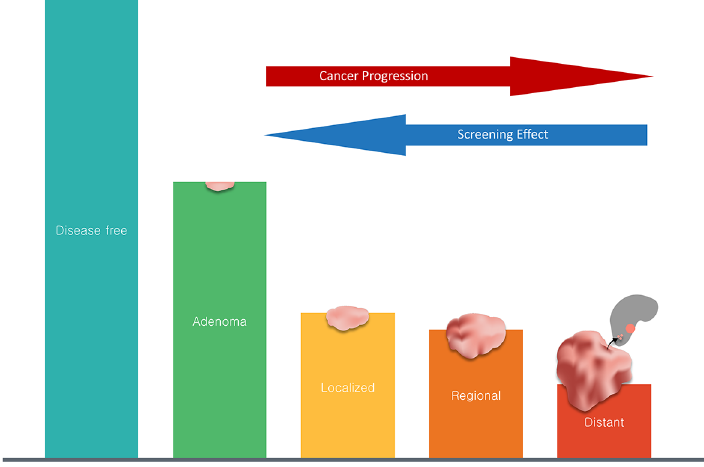
Fig 1. Model of a successful screening program. The widely accepted concept is that colonic neoplasia progress from less advanced to more advanced stages (from adenoma to localized to regional to distant) and become more symptomatic as they progress. As screening quality is improved and more people are being screened, as has been the case in the US since 2000, we expect a screening effect that reduces the incidence rates of all stages of disease. This model predicts that a successful screening program would exert its largest reduction in incidence on distant